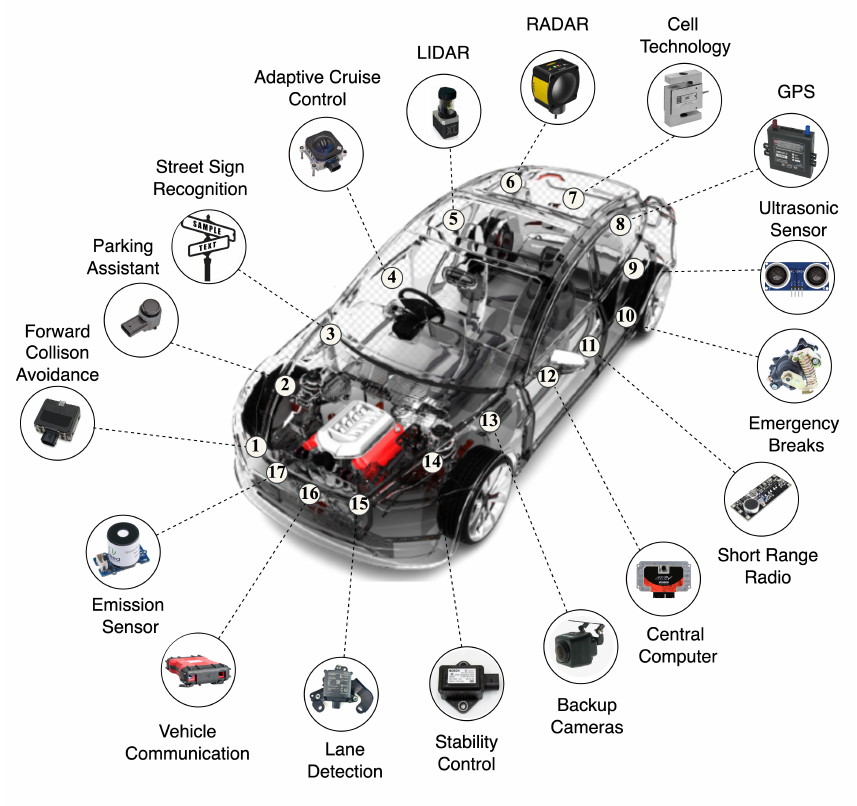
Figure 1. Illustration of numerous sensors and safety features of